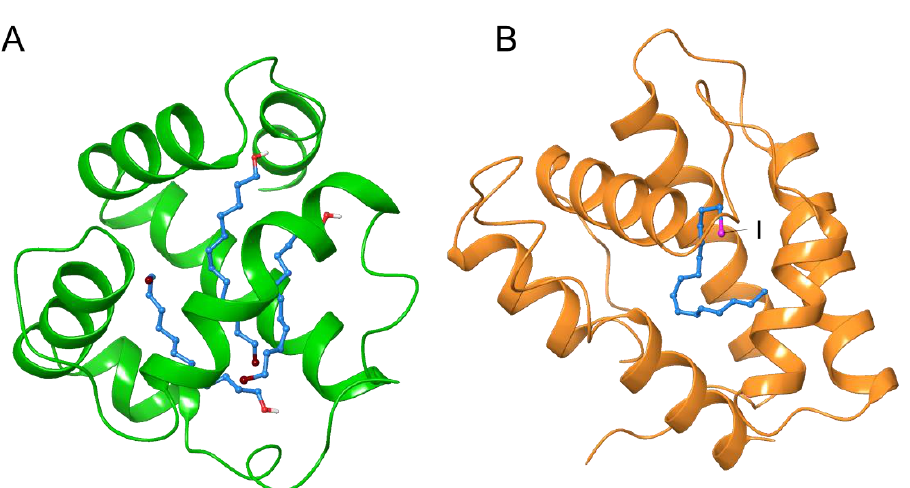
Figure 2. Crystal structures of the complex with lipidic ligands with halogen moiety. Moth chemosensory protein CSPMbraA6 with bromohydrocarbon chain (PDB ID: 1N8U) ( A ). Moth pher- omone binding protein BmorPBP with iodohexadecane (PDB ID: 2P71) ( B ). Hydrocarbon chain of